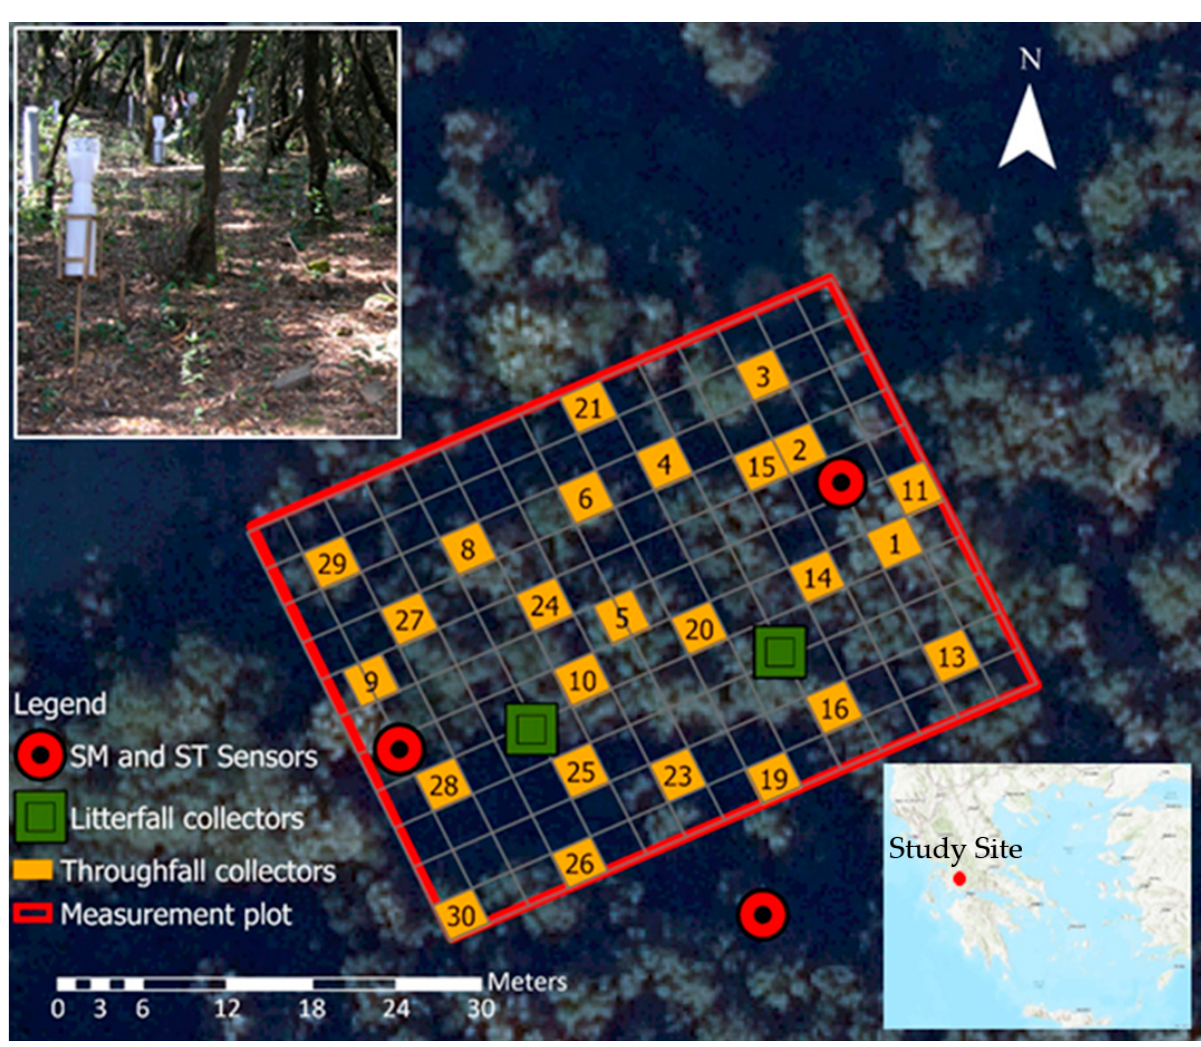
Figure 1. Experimental plot and installed monitoring equipment. The red dot of the map in the right corner indicates the study site.